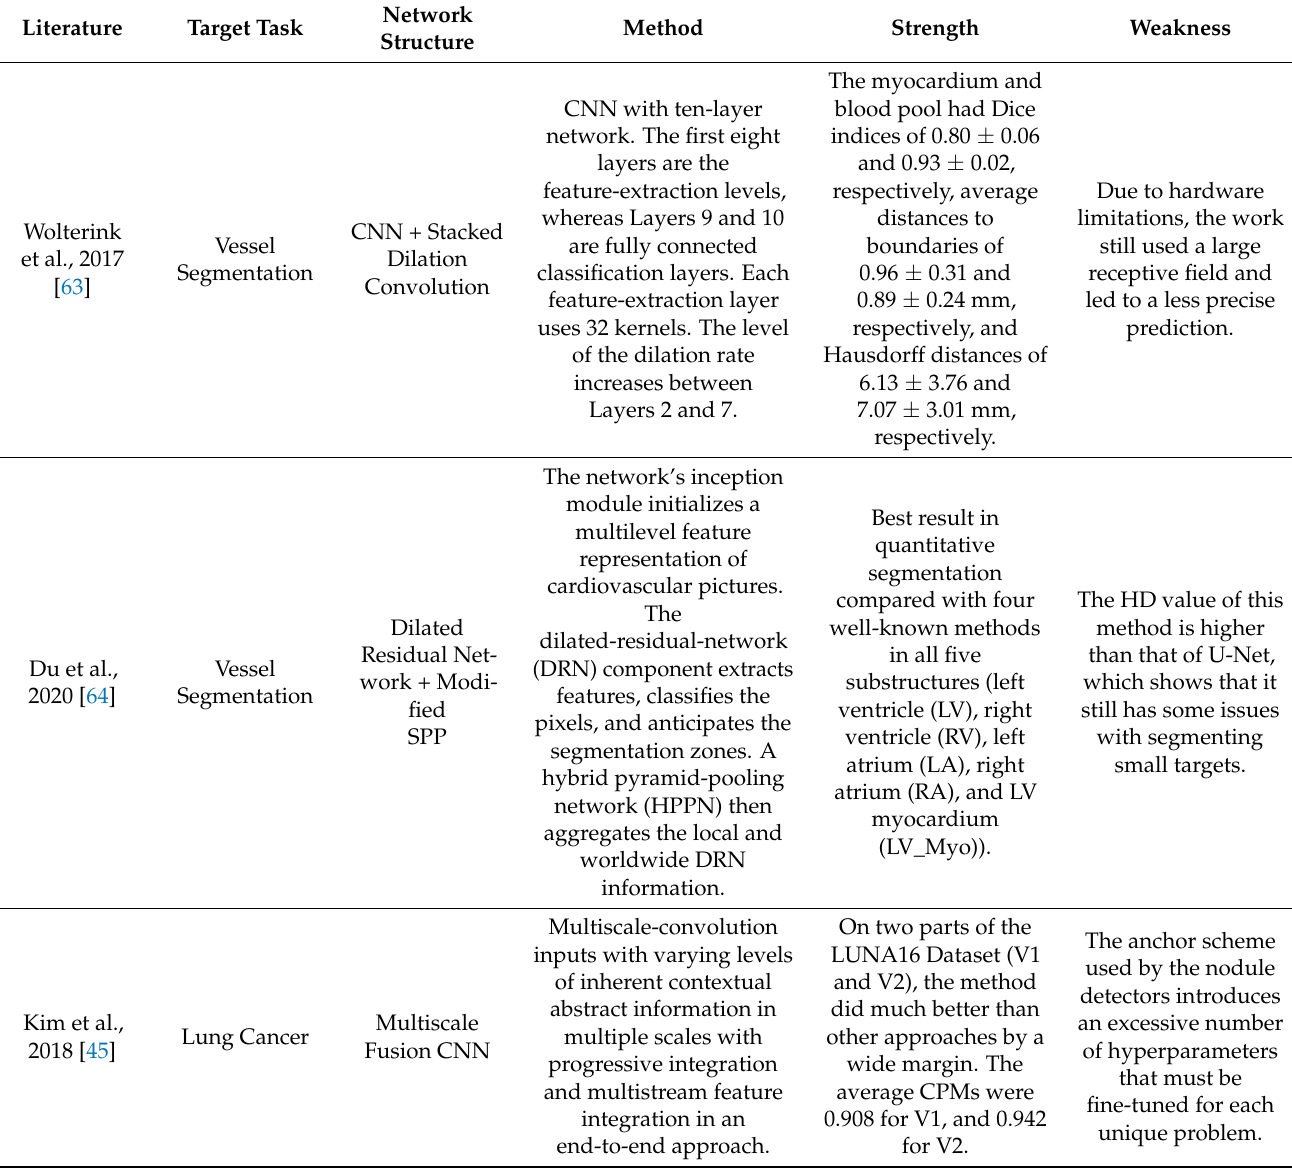
Table 2. The Application of Multiscale CNNs in Medical